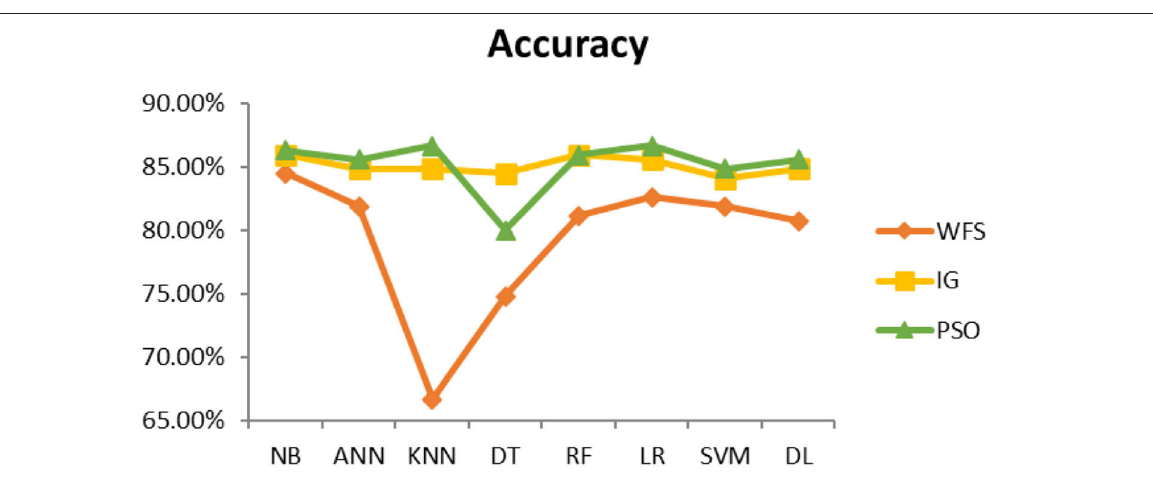
FIGURE 8 | Heart attack diagnosis accuracy (dataset